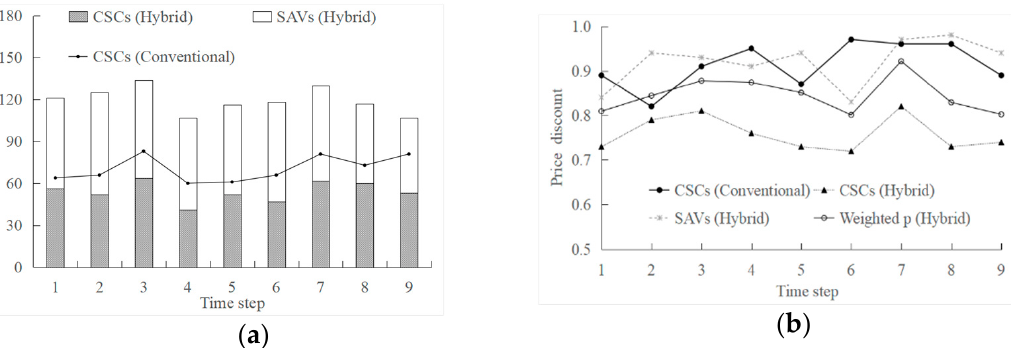
Figure 6. Performance of the carsharing system: ( a ) Number of carsharing trips, ( b ) Price discount.